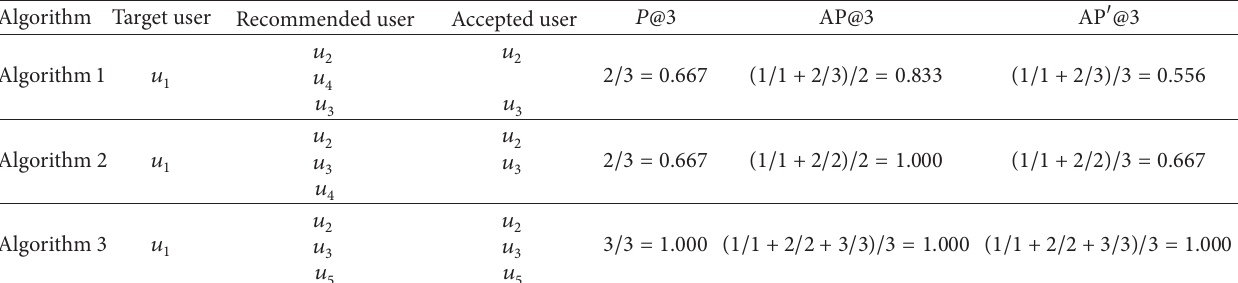
Table 1: Differences of applying different evaluation